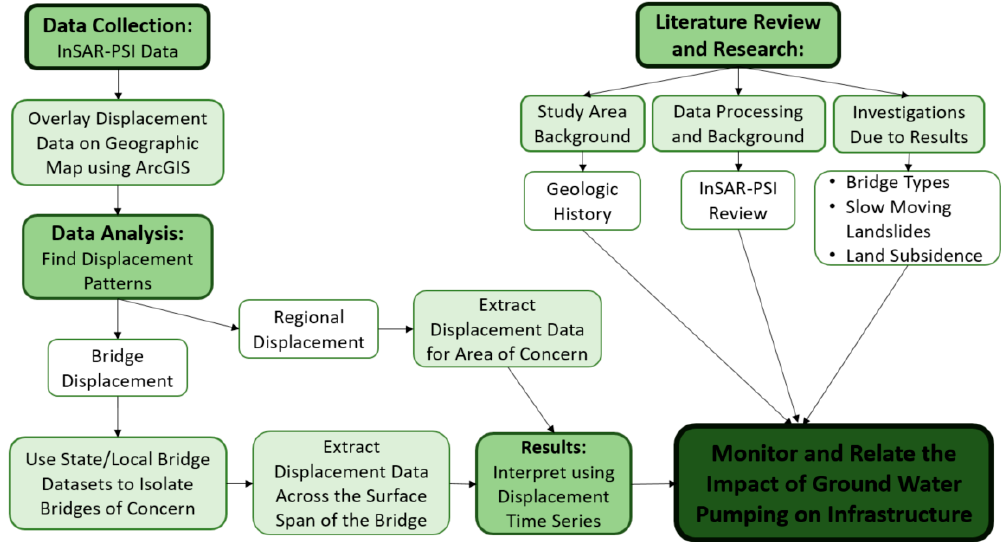
Figure 2. Chart summarizing the steps taken throughout the research process for monitoring the impact of groundwater pumping on infrastructure using GIS and PSI. impact of groundwater pumping on infrastructure using GIS and